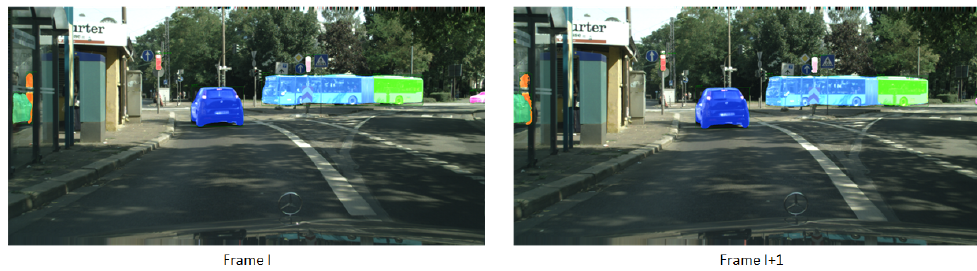
Figure 15. Wrong predictions propagation on the next frame: Mask RCNN prediction for Frame I , label and mask propagation using DIS for Frame I+1